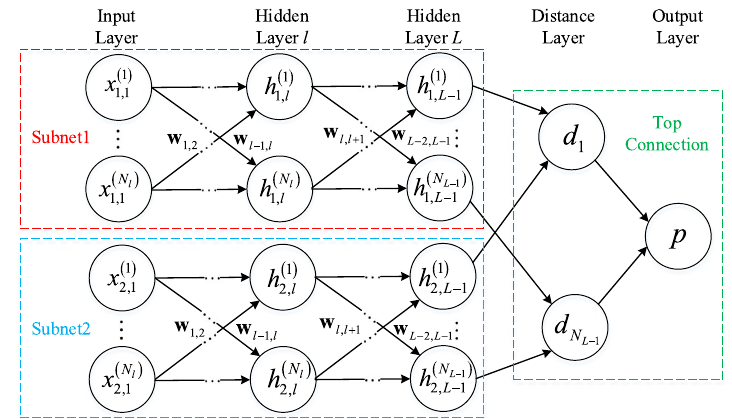
Fig. 3 Architecture of the Siamese neural